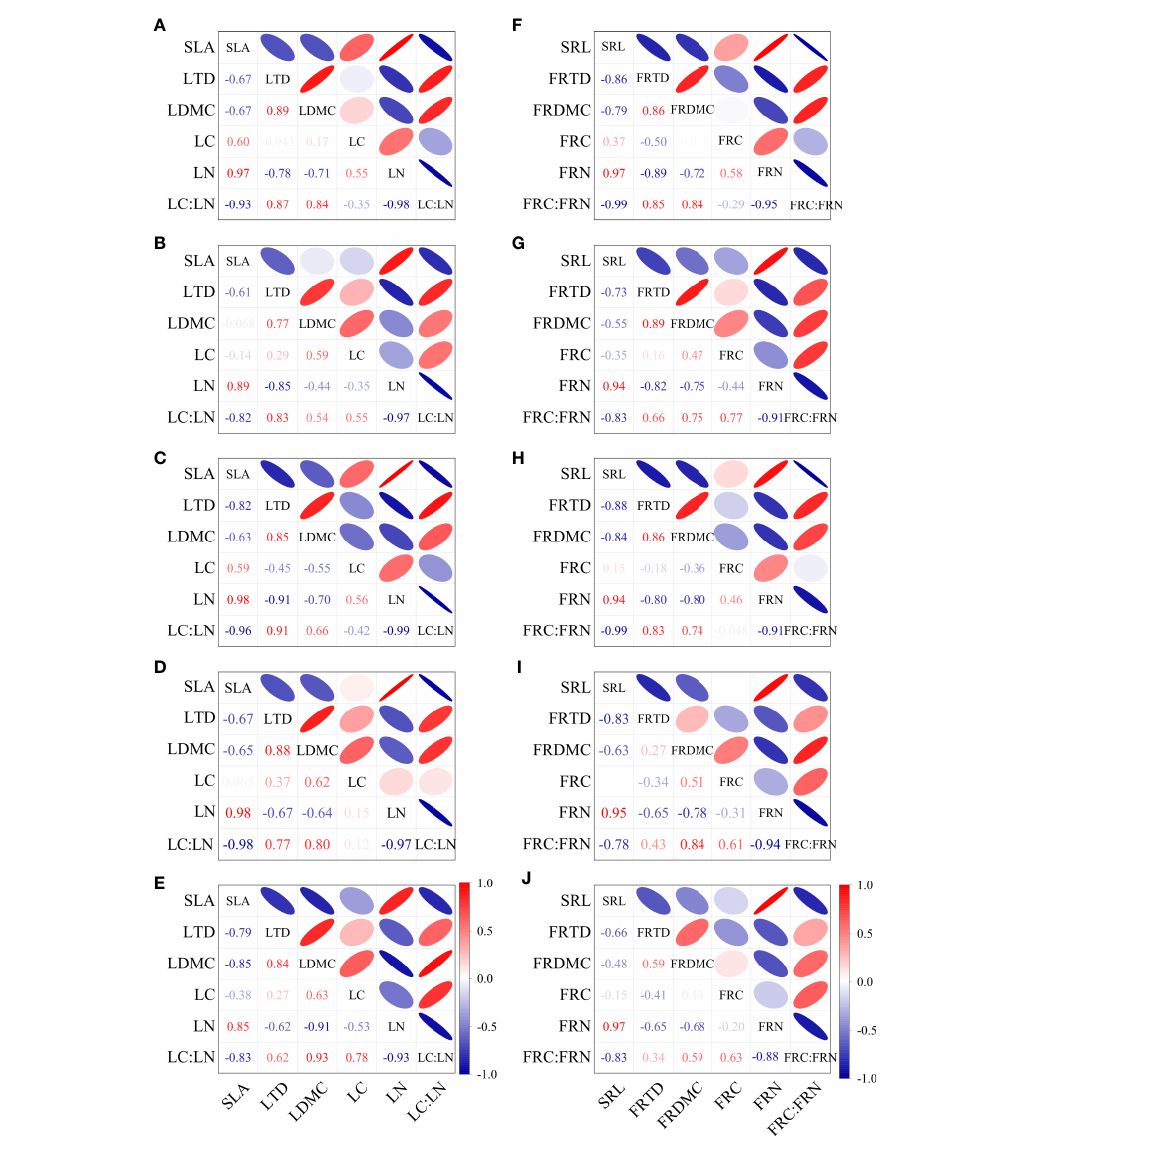
FIGURE 5 Correlations of leaf traits and of fi ne root traits at different stump heights (A – E) . Correlations of leaf properties at 0, 10, 15, 20 cm and no-stumping (F – J) . Correlations of fi ne root properties at 0, 10, 15, 20 cm and without stumping. (All abbreviations are shown in Figure